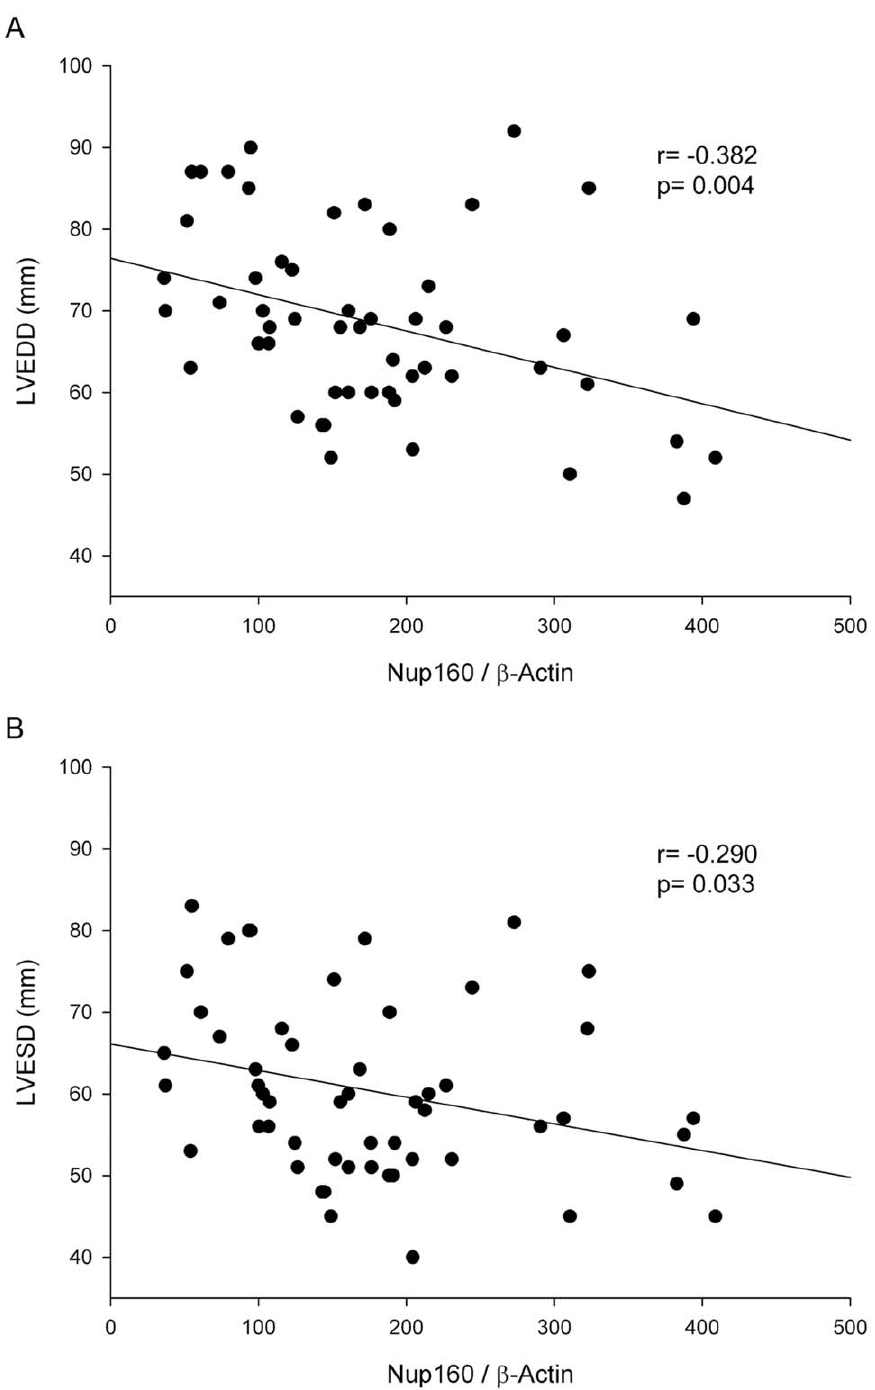
Figure 3. Relationships between Nup160 levels and ventricular function parameters. A) LVEDD (left ventricular end-diastolic diameter), B) LVESD (left ventricular end-systolic diameter) in HF patients group (ICM and DCM). Values are normalized to b -actin and finally to CNT group.